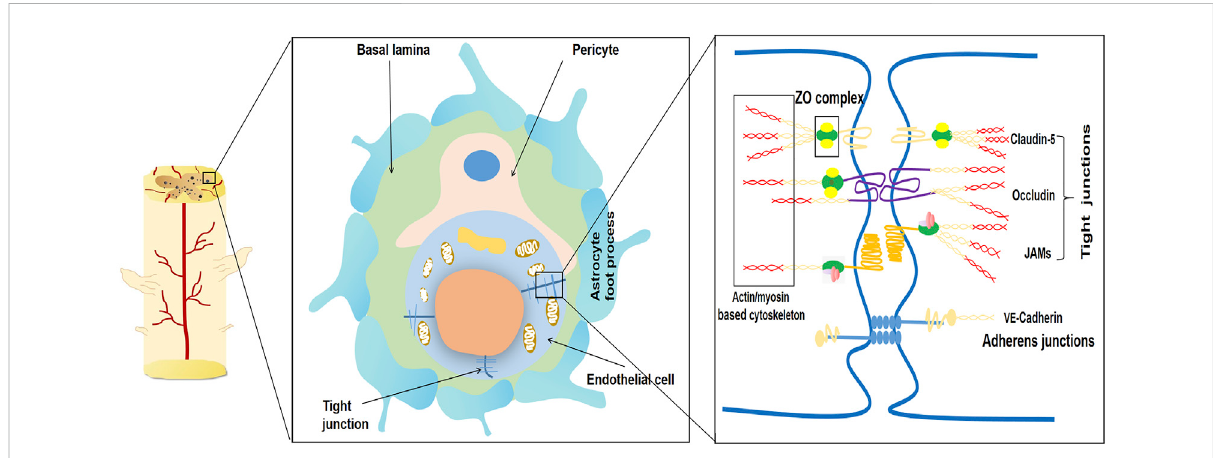
FIGURE 1 Schematic diagram of the main components of the blood-spinal cord barrier (BSCB). The blood-spinal cord barrier typically consists of endothelialcellswithnoporesattachedtotightjunctions(TJ),basallayer,pericytes,andastrocytefootprocesses.ThepermeabilityofBSCBismainly regulated by connexins and their complex molecular structure between endothelial cells. The typical tight junctions consist of Occludin, Claudins, ZO complex and adhesion junction. Adhesion junctions act as continuous bands in the plasma membrane and allow high levels of adhesion between endothelial